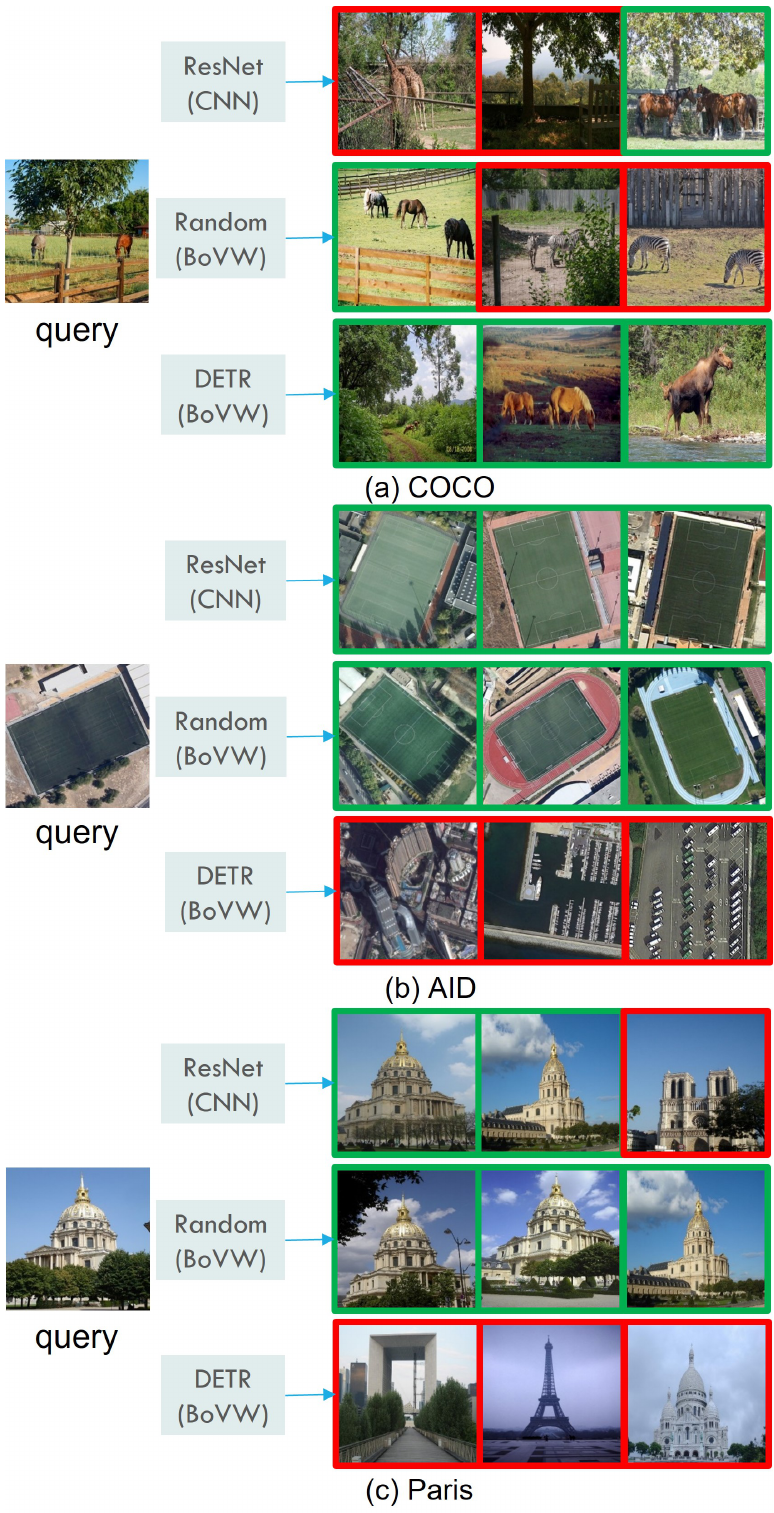
Figure 10. The results of image retrieval for single-subject